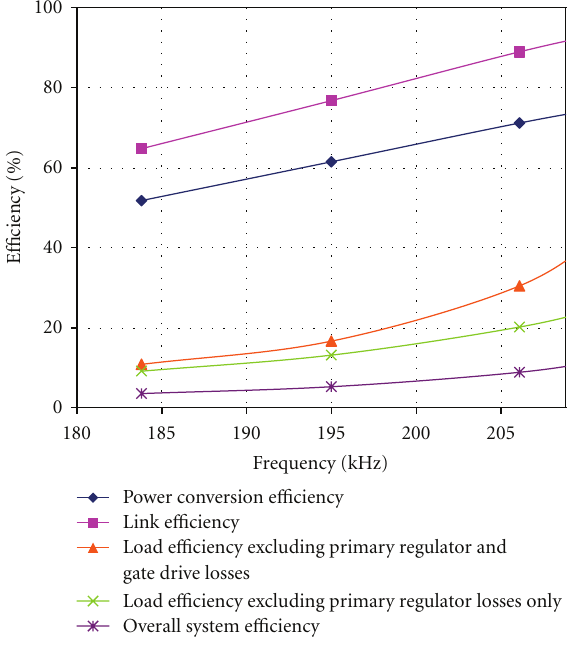
Figure 7: E ffi ciency versus the operating frequency plots.